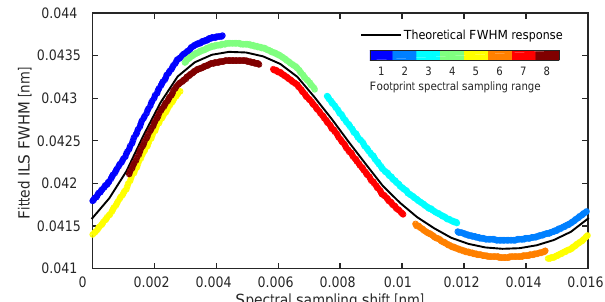
Figure 12. The black line shows the derived ILS FWHM using the hybrid Gaussian function at a sliding OCO-2 spectral sampling grid (same as the “Hybrid asym” line in Fig. 11a). The color lines show the range of the wavelength Doppler shift of the spectral sampling grid for each footprint, relative to the spectral sampling grid of foot- print